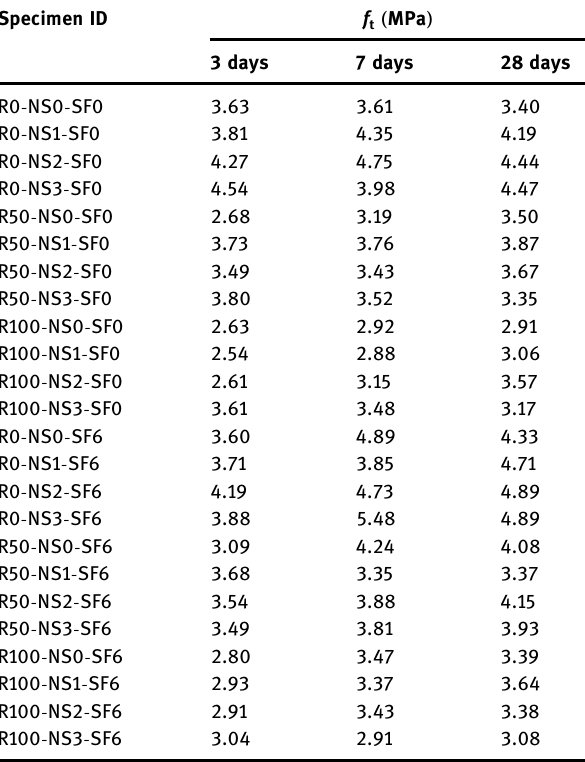
Table 8: Experimental results of split tensile strength Specimen